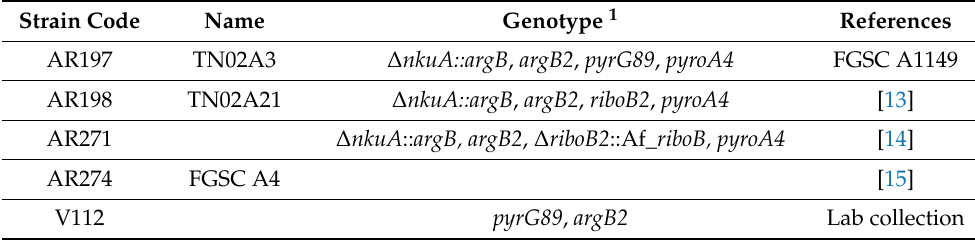
Table 1. Aspergillus nidulans strains used in this study. Strain